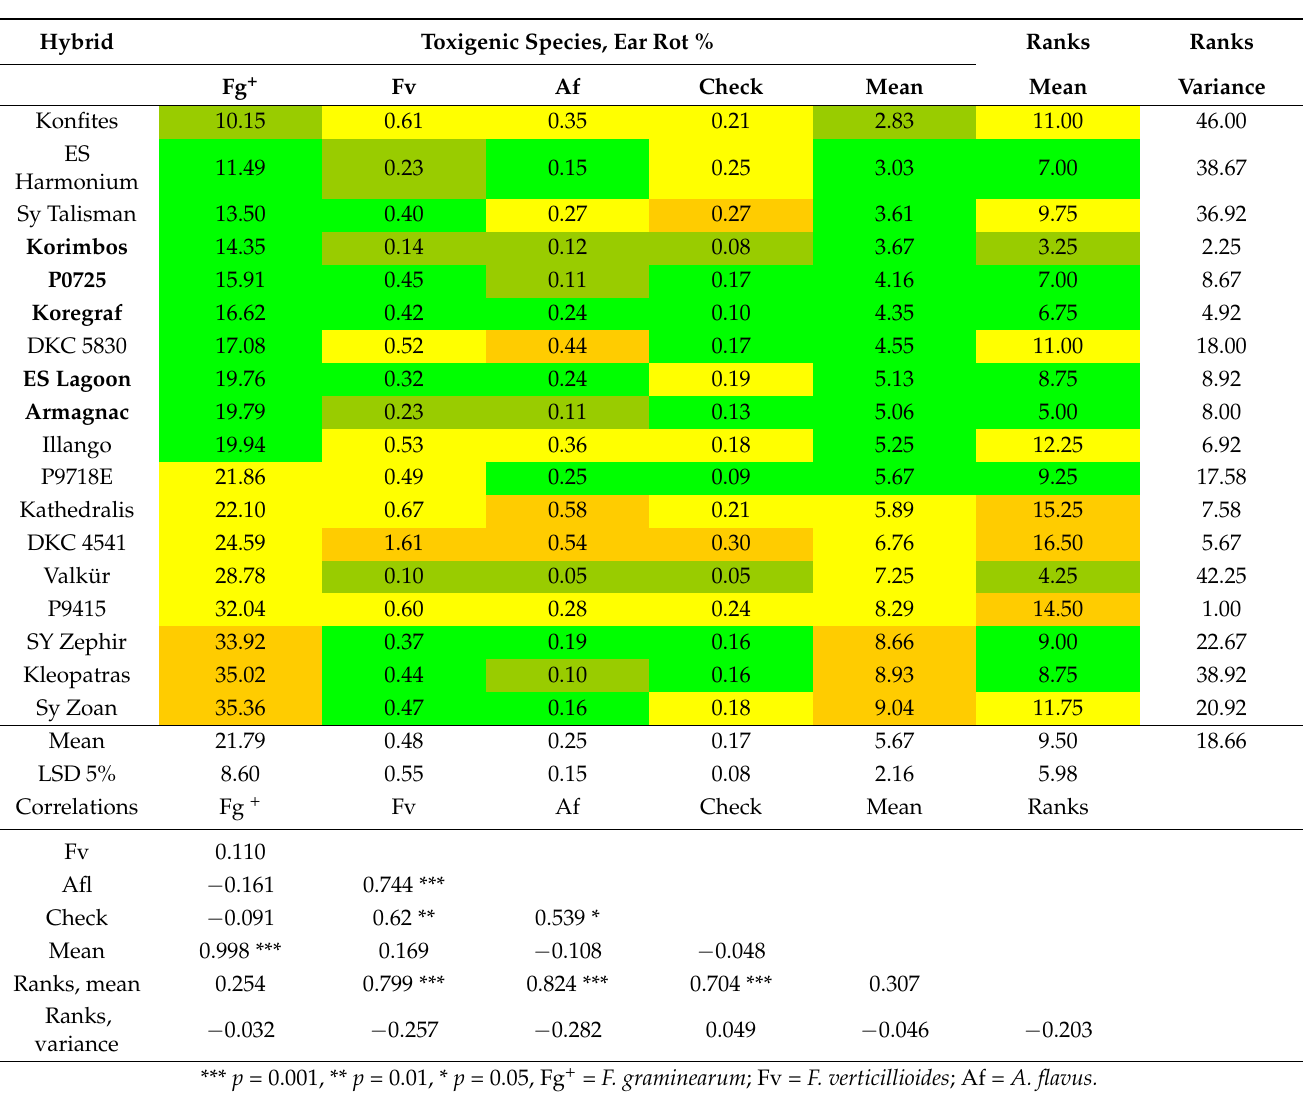
Table 5. Kernel resistance test of commercial maize hybrids against toxigenic fungi and ear rot severity. Data are shown as percentages (2019–2020, Szeged,